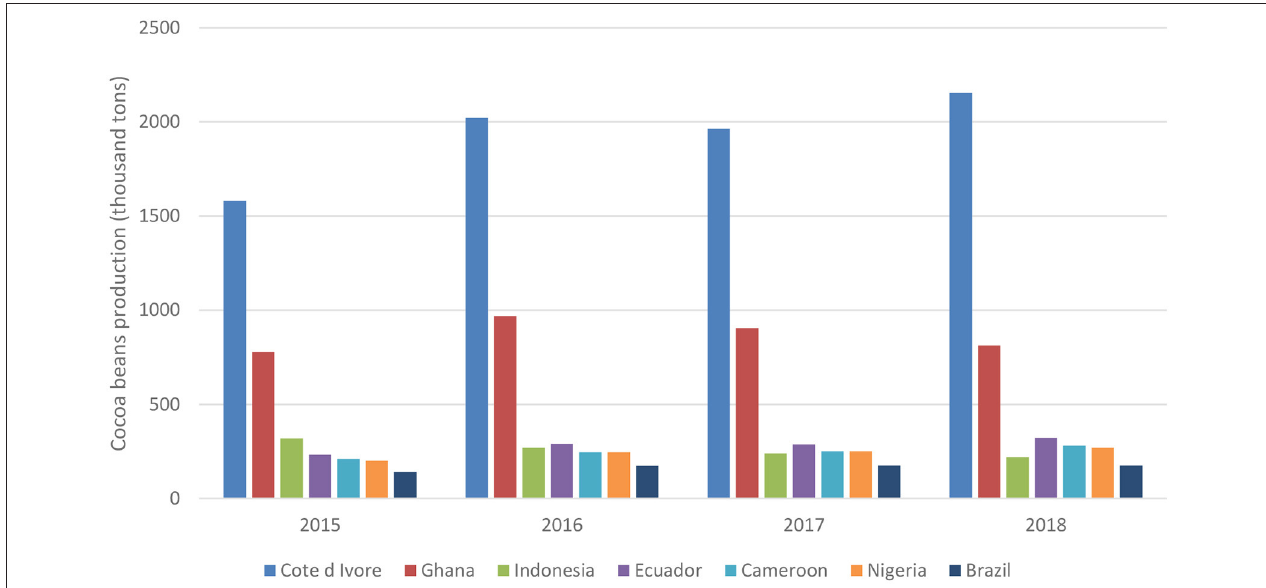
FIGURE 4 | Development of cocoa bean production in major producing countries, 2015–2018 (thousand tons). Source: (ICCO, 2018, 2019, 2020) (processed